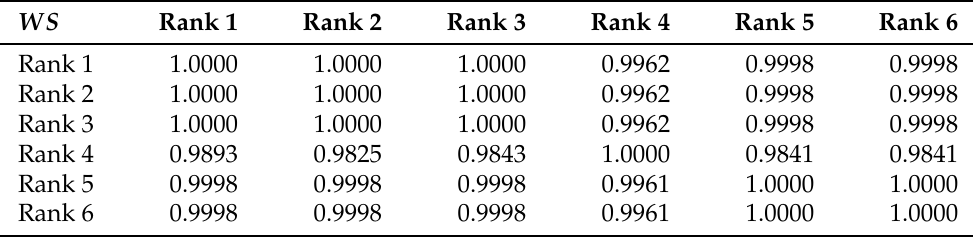
Table 20. Correlation matrix for WS values for candidate compromise rankings with consideration of the whole